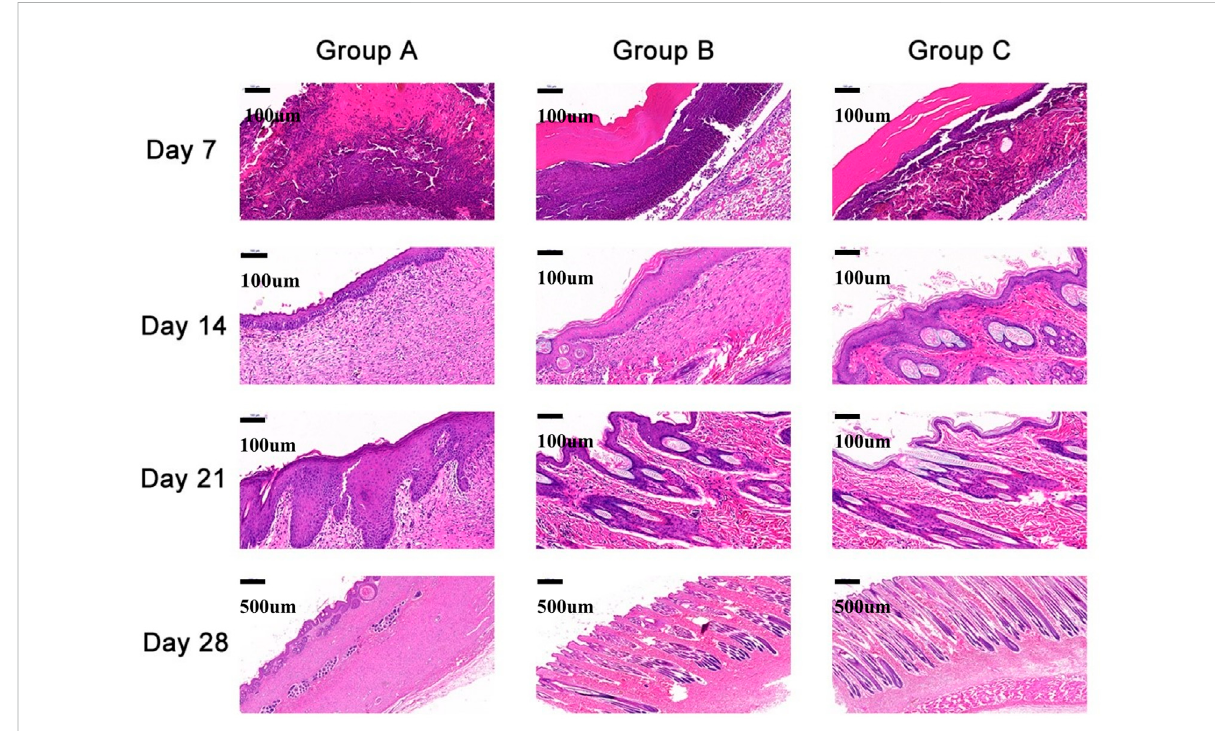
FIGURE 6 Representative images of H&E-stained histologic wound sections of group (A – C) .